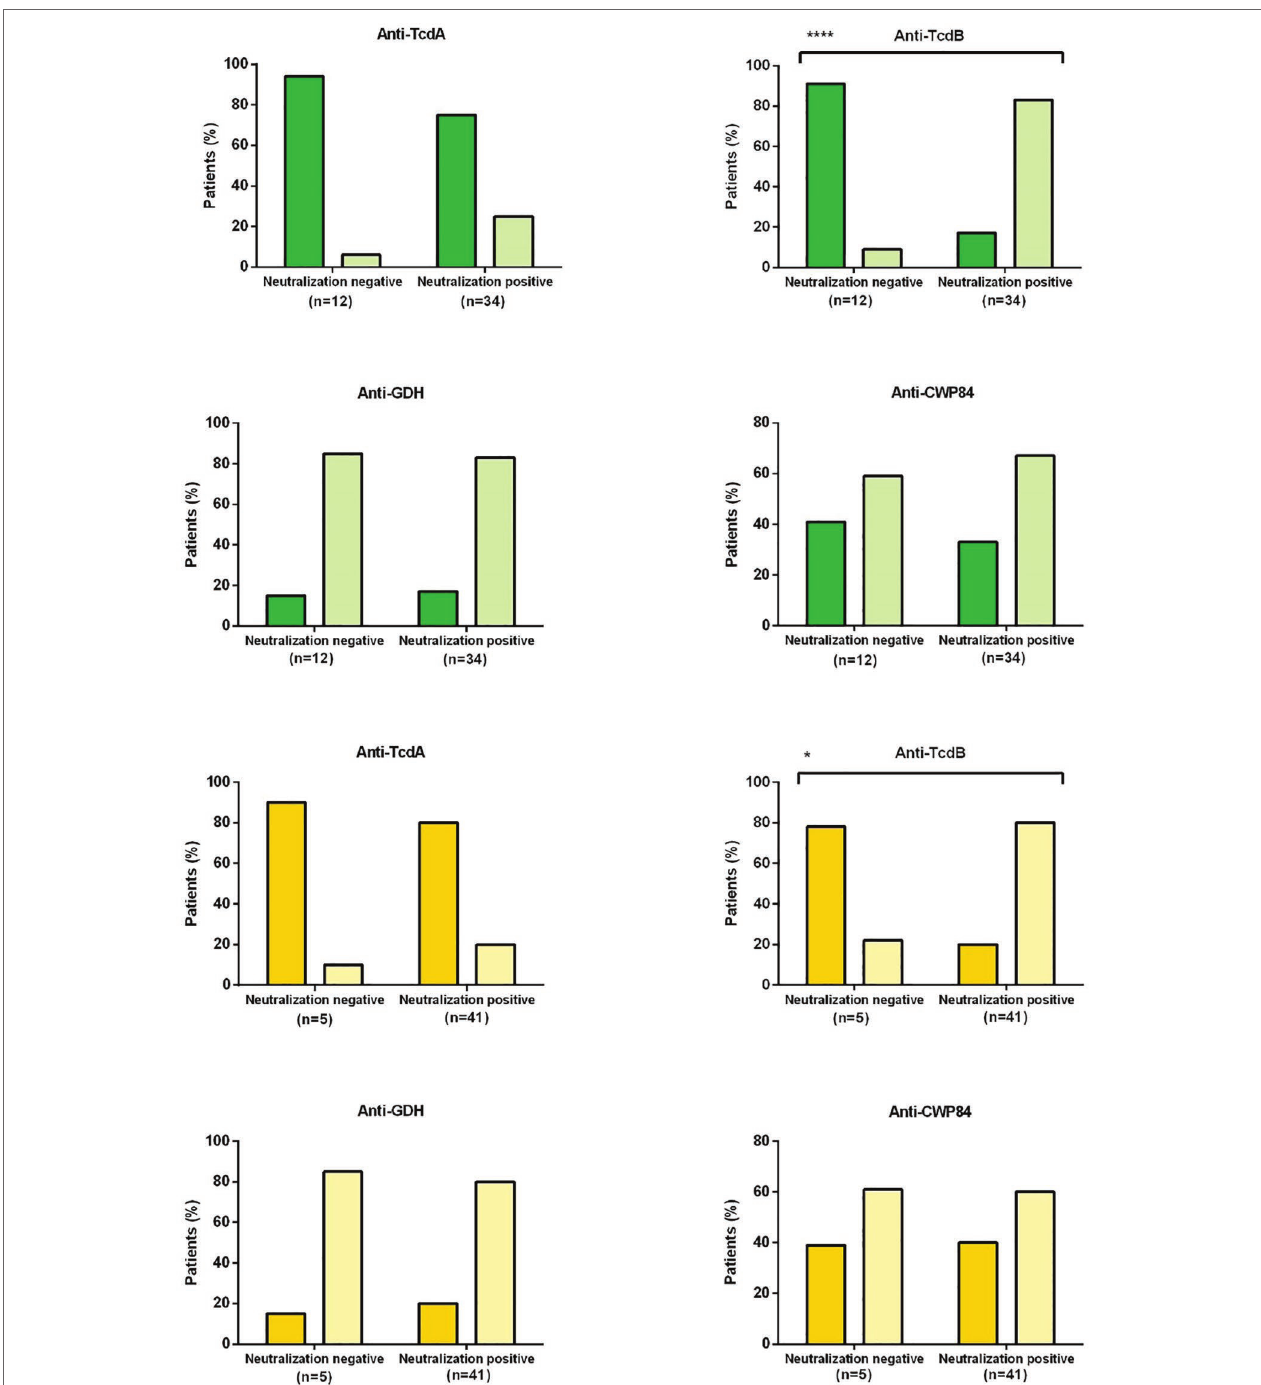
FIGURE 3 | Correlation between enzyme immunoassay (EIA) and toxin neutralization assay (NT). The bars represent the percentage of patients with neutralizing or non-neutralizing antibodies (x-axis) and positive (light color) or negative (dark color) ELISA antibodies. Green bars refer to studies with conditioned medium of RT 027 and yellow to studies with conditioned medium RT014. Dark green or dark yellow: ELISA antibodies negative; light green or light yellow: ELISA antibodies positive TcdA, Toxin A; TcdB, Toxin B; GDH, glutamate dehydrogenase; CWP84, cell-wall protein 84. A significant correlation was found between anti-TcdB with neutralization of RT027 toxins (**** p = 0,0001) and RT014 toxins (* p =